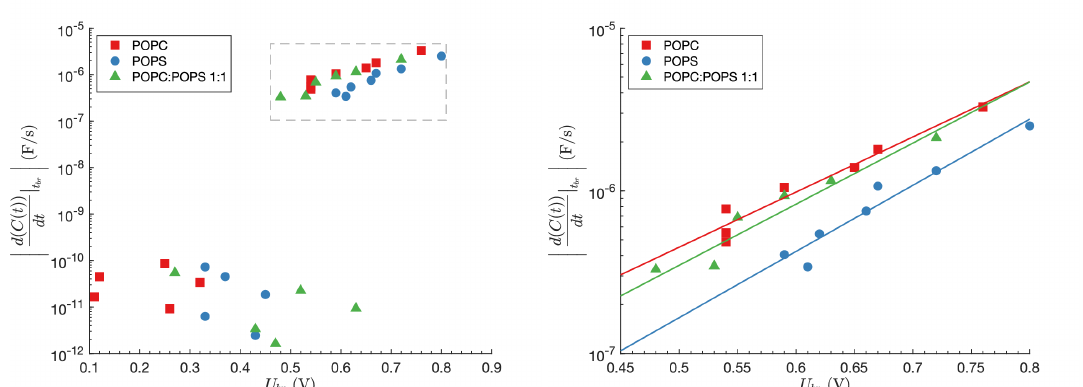
Figure 3. Left side of the figure presents the rate of the planar lipid bilayer capacitance change at t br as a function of breakdown voltage U br . Results regarding fast rise of transmembrane voltage are enlarged on the right side. Slope m of the ) and U linear relation between ln ( dC br is related to pore radius. See text for details. dt